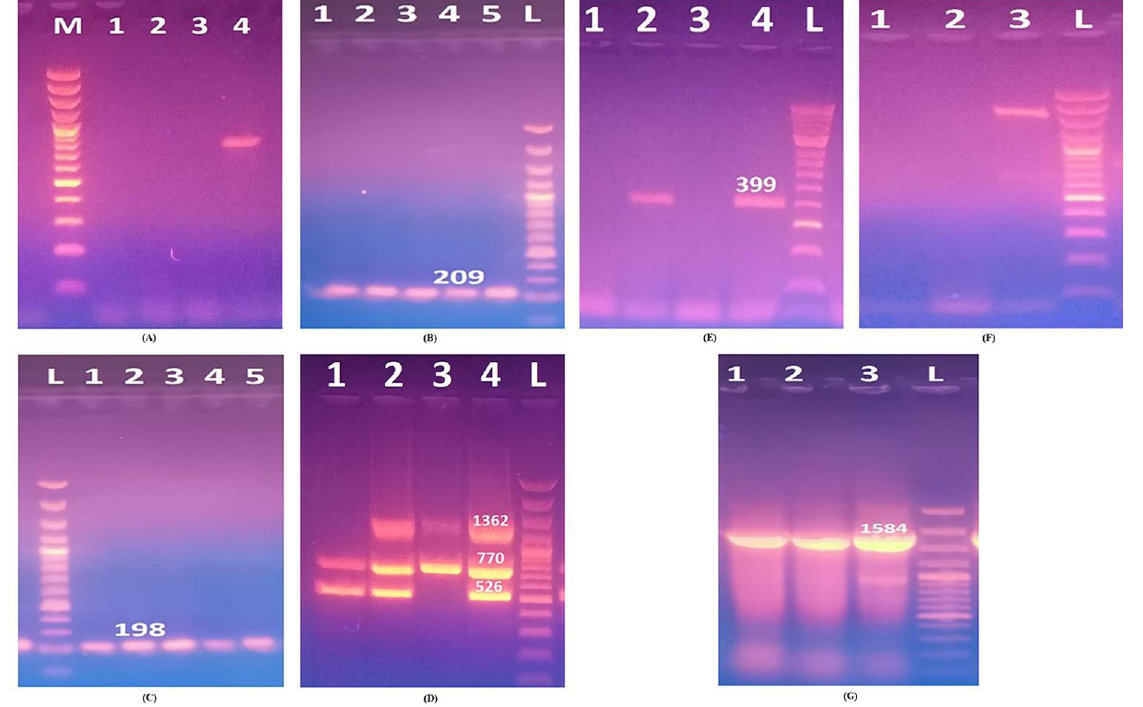
Figure 1A-G. A Ethidium bromide-stained agarose gel showing the band of amplified PCR product 767 bp sdrE gene at lane 4. L: DNA ladder, Lane 1-3 are sdrE negative, B Lane L, 100-bp DNA ladder; lanes 1-5, the 209-bp PCR product of hla gene, C Lane M, 50-bp DNA ladder; lanes 1-5, the 198-bp PCR product of icaD , D The electrophoresis result of amplified multiplex PCR product of icaA, fnbpA and ebpS genes at 770 bp, 1362 bp and 526 bp, respectively. Lane (L): marked 100-bp DNA ladder , E Lane L, 50-bp DNA ladder; lanes 2 and 4, the 399-bp PCR product of sirB , F Ethidium bromide-stained agarose gel showing the band of amplified PCR product 1722 bp cna gene at lane 3. L: DNA ladder, Lane 1 and 2 are cna negative , G Lane L, 100-bp DNA ladder; lanes